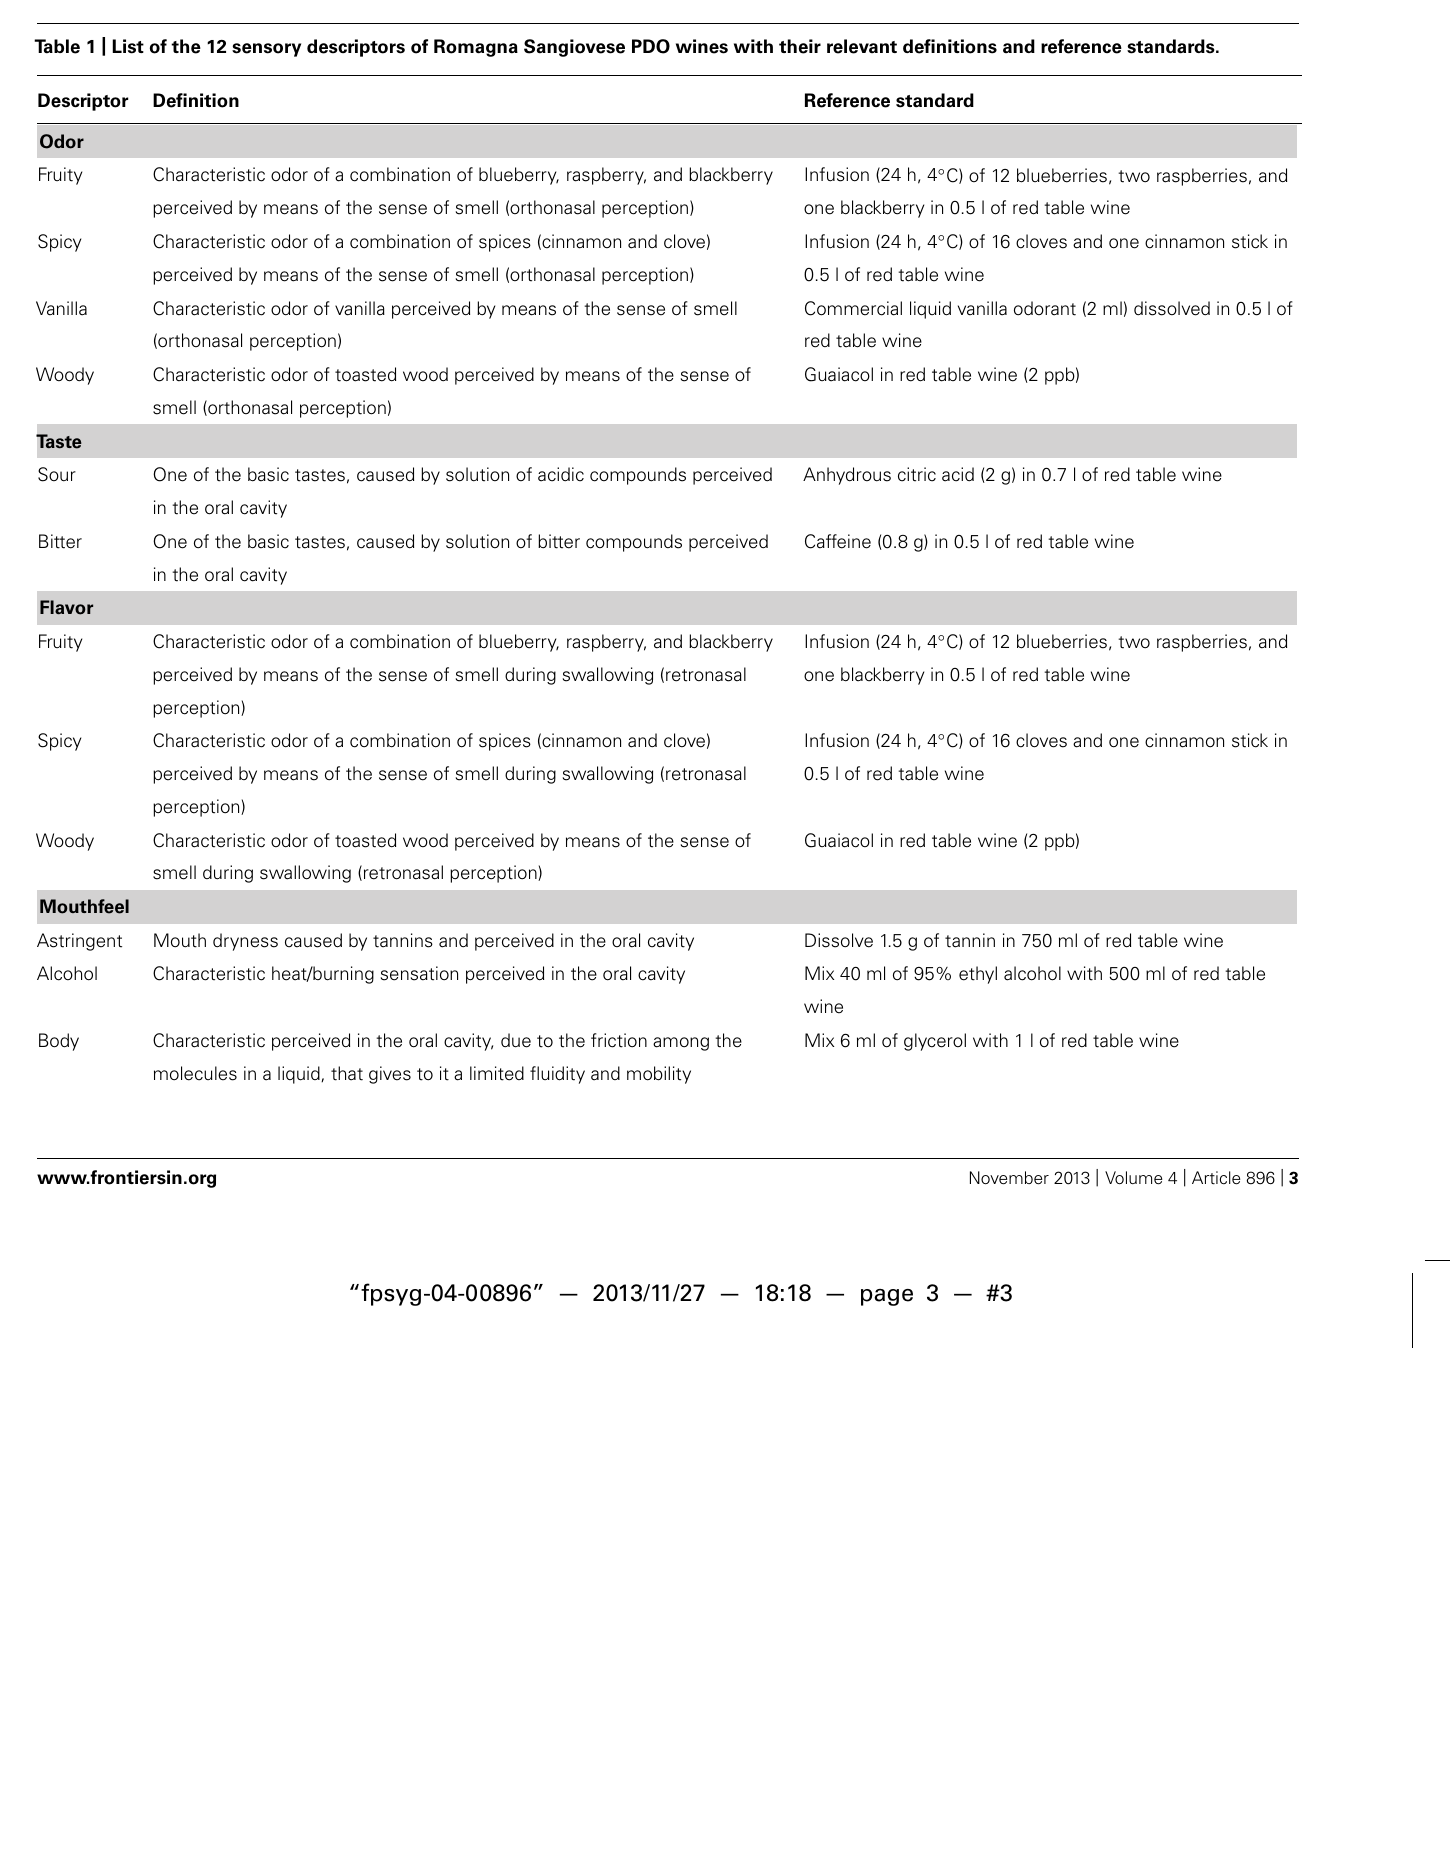
Guaiacol in red table wine (2 ppb)